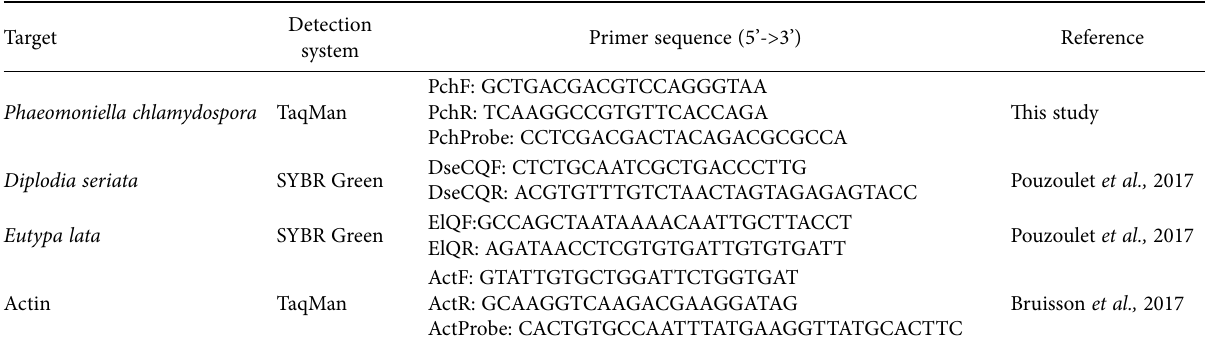
Table 1. Oligonucleotides used on this